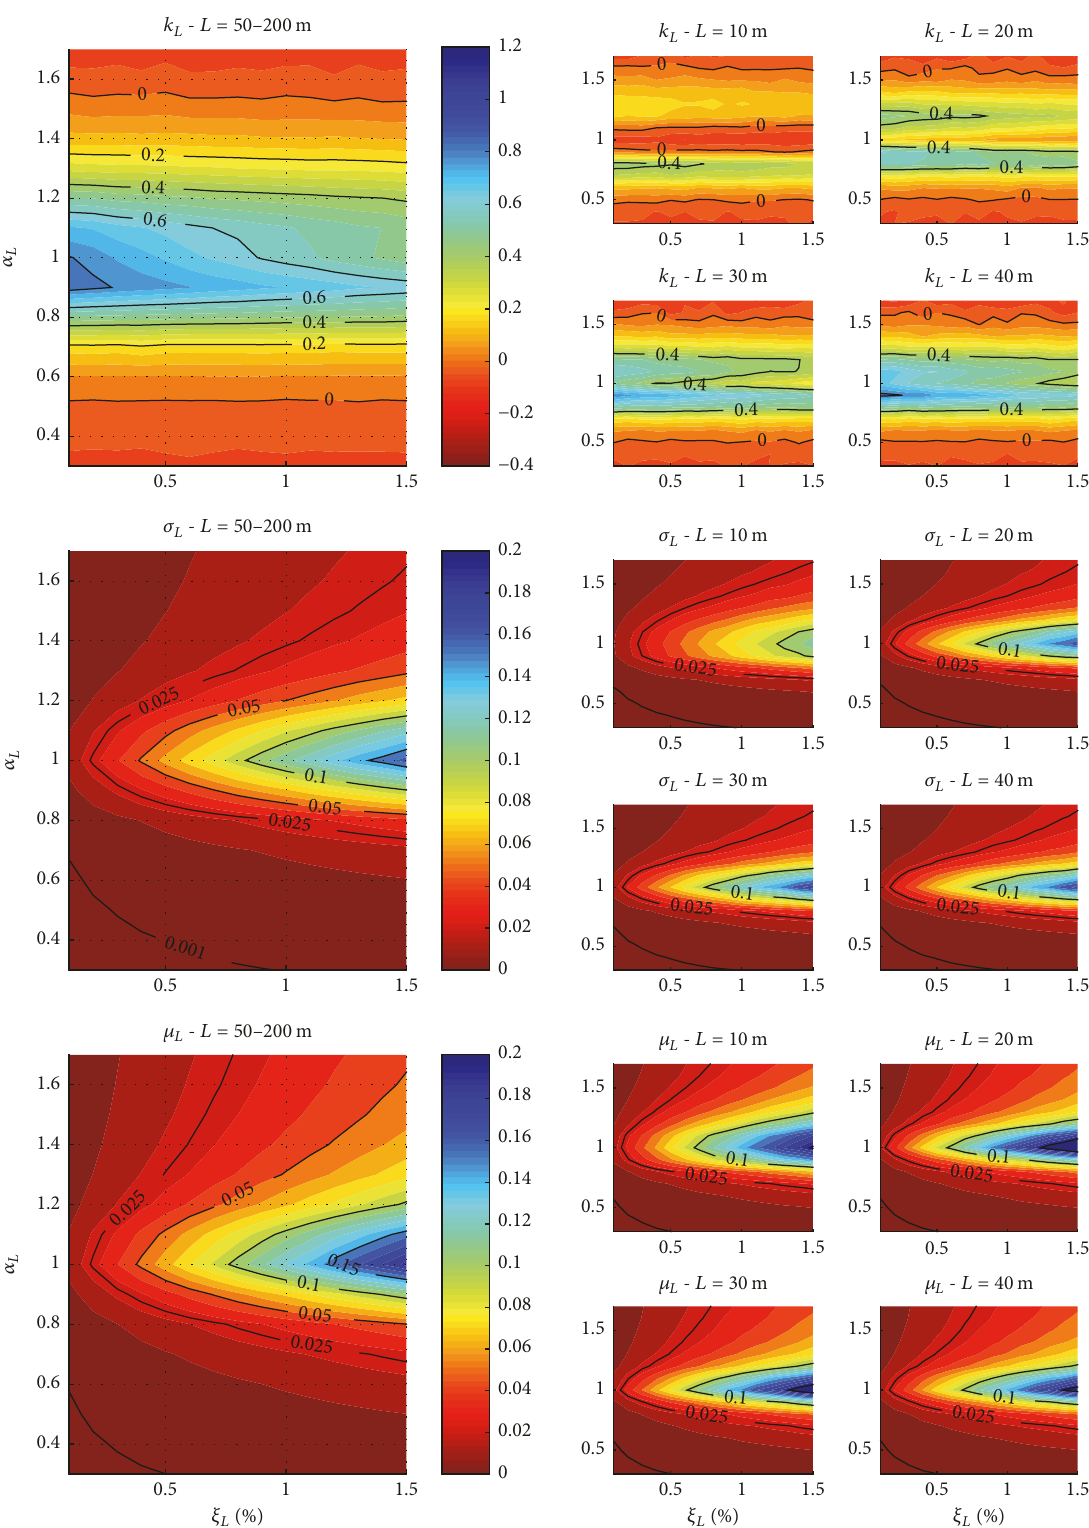
(𝜑 ( RL = 1, 𝛼 ,𝐿,𝜉 )) : double clamped case in lateral 𝐿 𝐿 𝐿 𝐿 𝐿